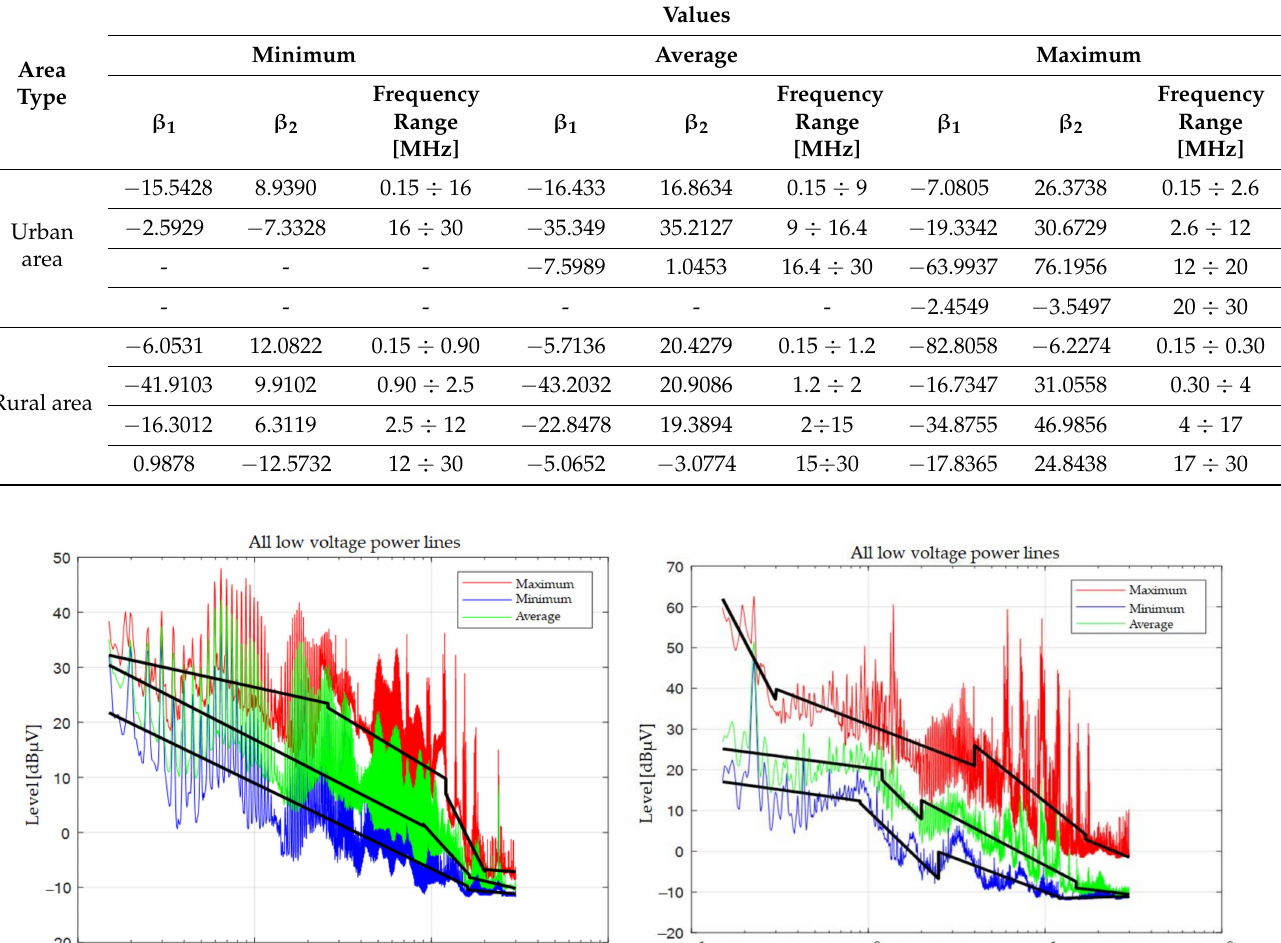
Table 1. Values of factors β 1 and β 2 of the approximating function (7) for the measured values of voltage levels for conducted environment noise U n,9kHz for various frequency bands and measurement location.